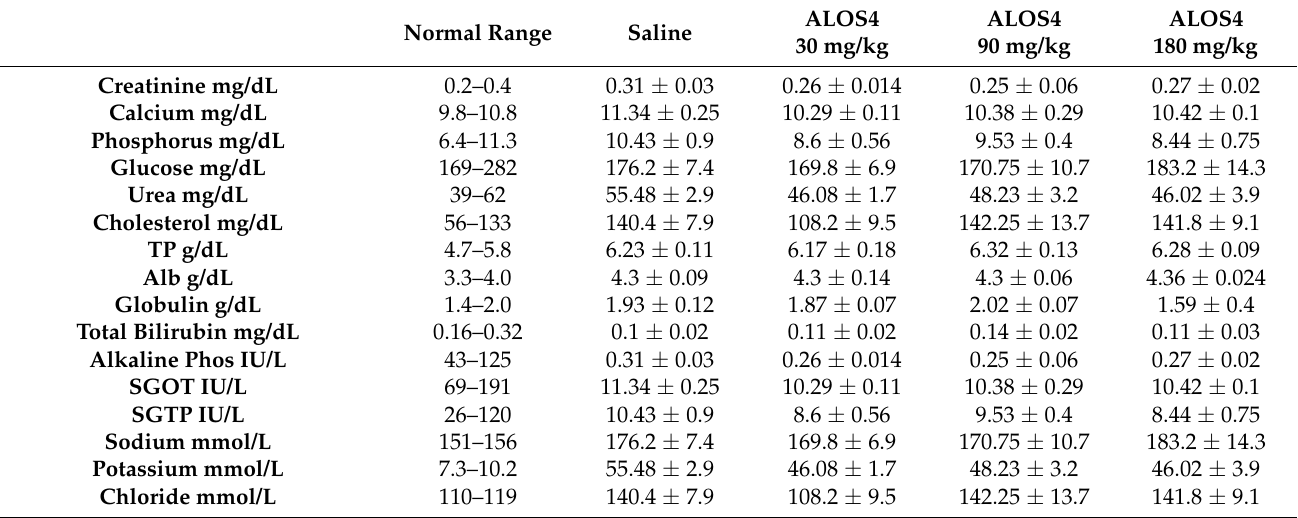
Table 2. Plasma Biochemistry of ALOS4 treated ICR